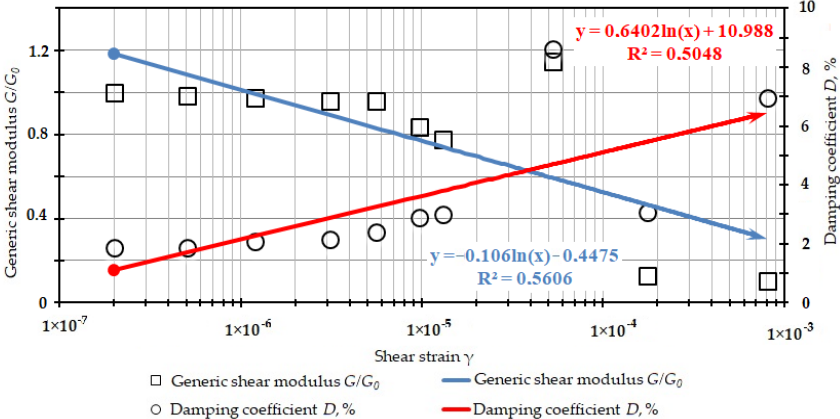
Figure A3. Graph of dependencies of generic shear modulus G/G 0 (unit fractions) and damping coefficient D (%) on the amplitude of shear strains γ (unit fractions) for cement stabilized soils. Test 3 (resonant column).